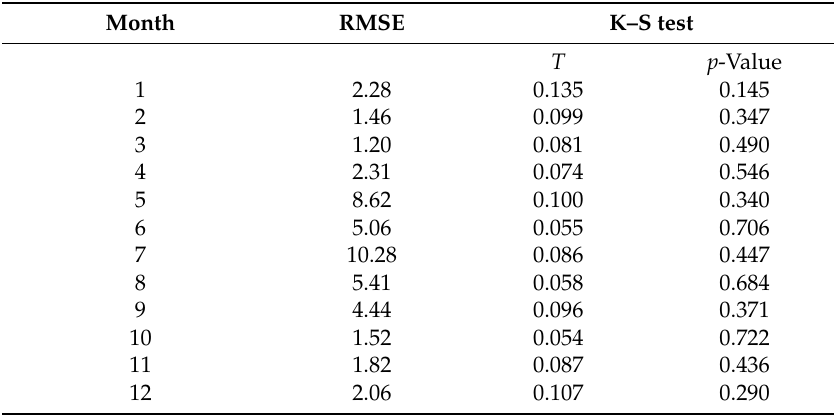
Table 2. The root means square error (RMSE) value and Kolmogorov–Smirnov (K–S) test for marginal distribution of monthly